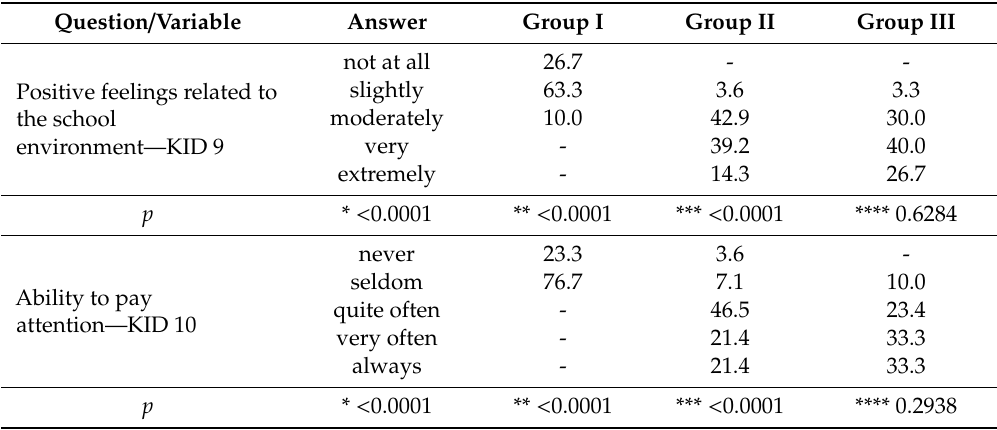
Table 9. School-related environment, concentration, and attention. The percentage of the respondents providing a given answer